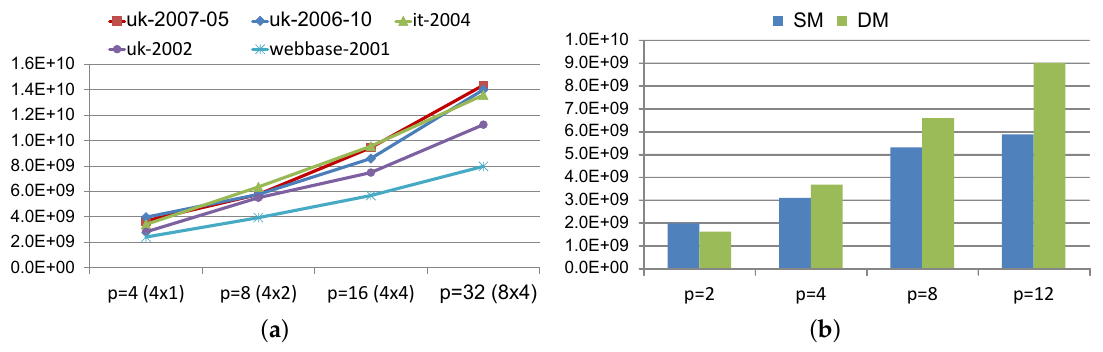
Figure 4. Performance of the MSTEP algorithm, q = 2, (cid:101) = 10 − 6 , α = 0.99. ( a ) DSM (Flops). ( b ) SM versus DM, uk-2007-05